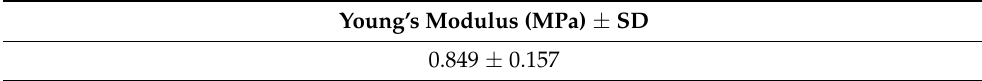
Table 2. The Young’s modulus value of curdlan/whey protein isolate-based biomaterial.